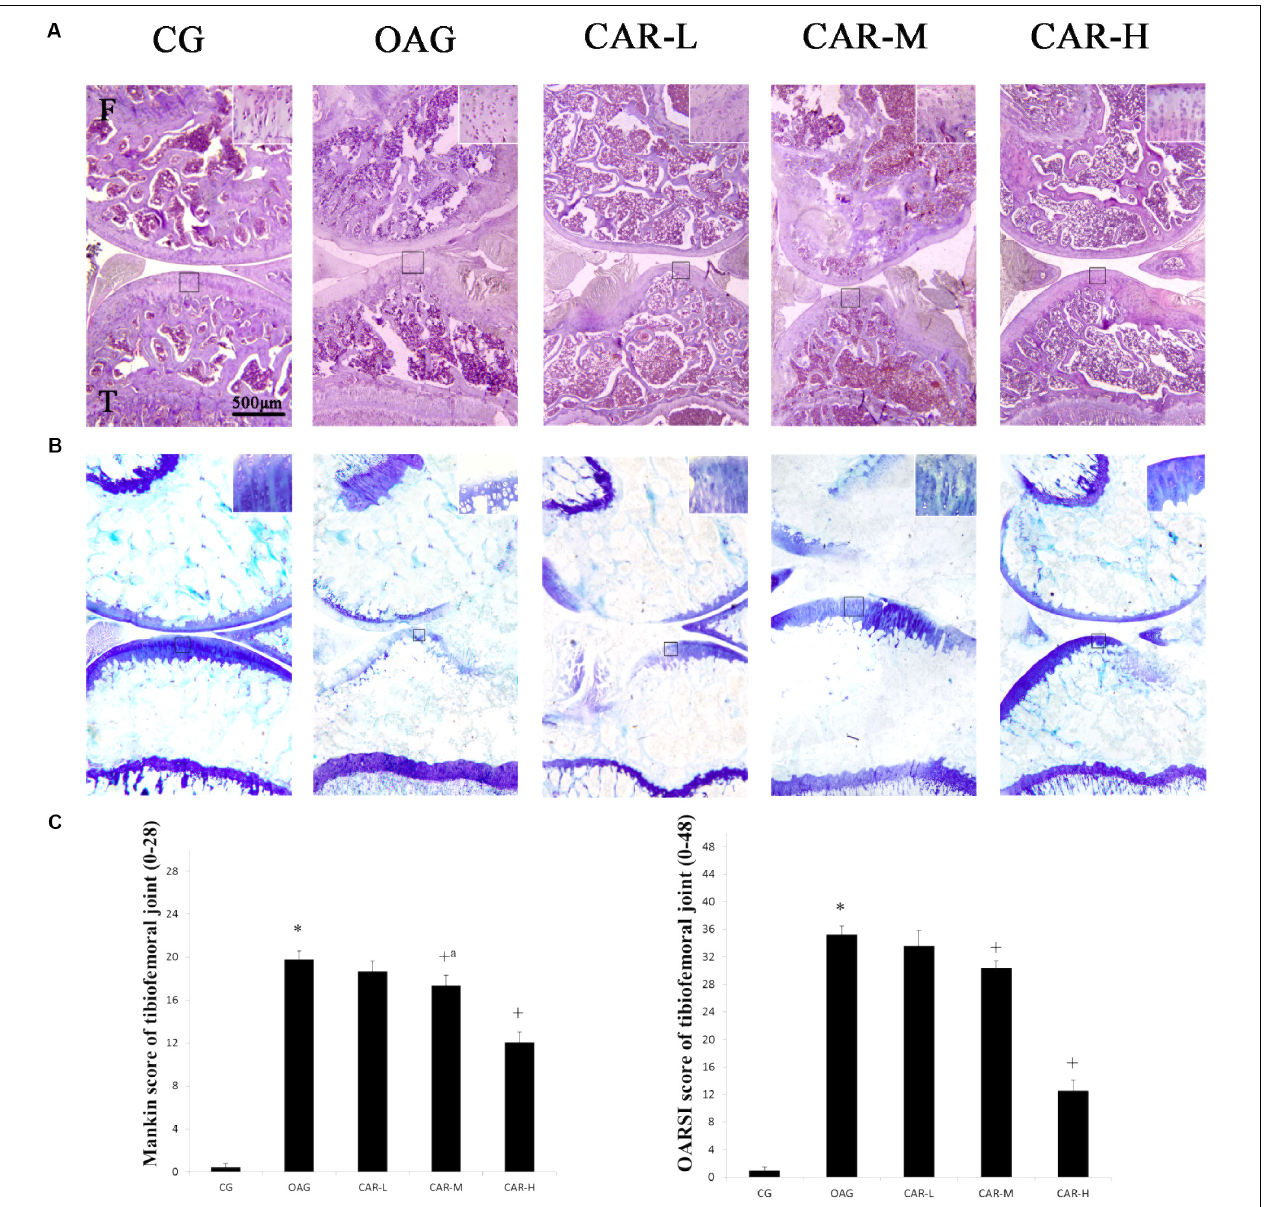
FIGURE 2 | Histological evaluation of the tibiofemoral joints. (A) Histological features of representative tibiofemoral joints sectioned in the sagittal plane stained with hematoxylin and eosin and toluidine blue. Mankin and OARSI histological scores are shown for each image. F, femur; T, tibia. (B) Mankin score for the tibiofemoral joints. Differences between CG and OAG ( ∗ P < 0.001), OAG vs. CAR-M and CAR-H groups ( + a P = 0.002, + P < 0.001) were significant. (C) OARSI histological scores for tibiofemoral joint cartilage. Differences between CG and OAG ( ∗ P < 0.001), OAG vs. CAR-L, CAR-M, and CAR-H groups ( + P < 0.001) were